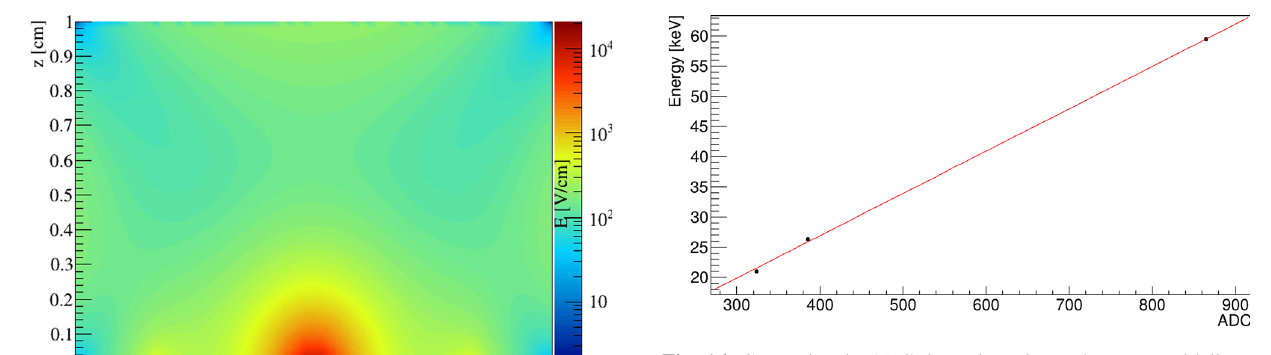
Fig. 16 Converting the ADC channel number to the energy with linear calibration function of E = p 0 + p 1 · A , where E is the energy in keV, A is the ADC channel number, and p 0 and p 1 are the fitting parameters with p 0 the intercept in keV and p 1 the slope V and 400 V, respectively, when the source was placed at the bottom of the cryostat. The x-axis is the energy in keV,